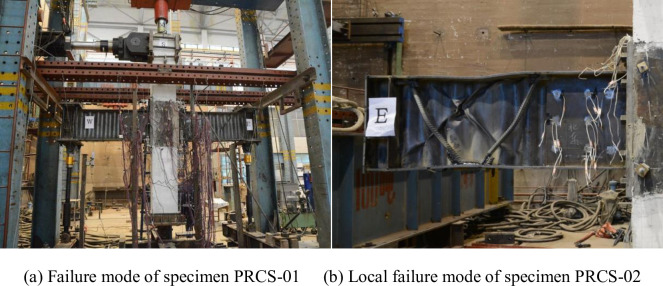
Local failure modes.